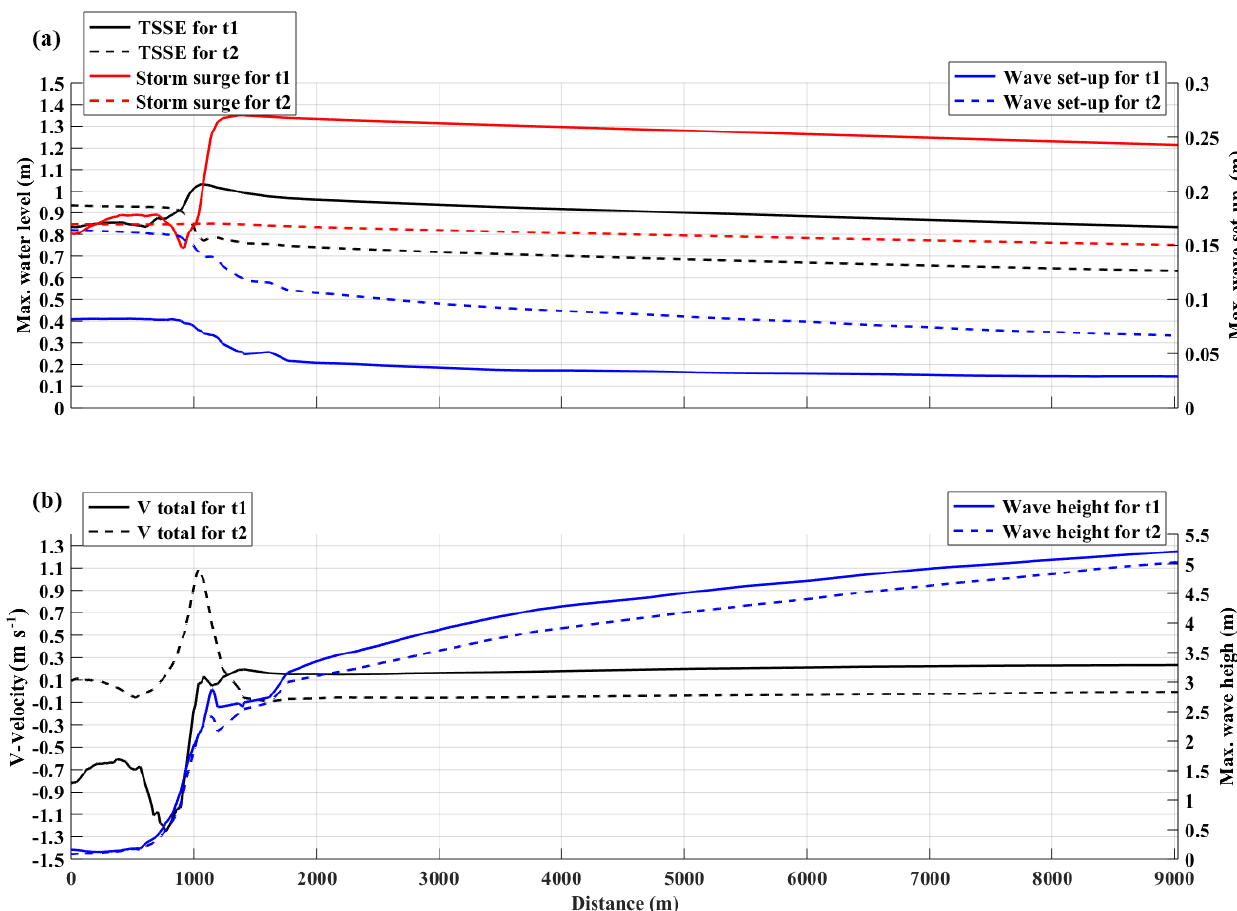
Figure 11. Modulation of the wave set-up for the ebb/flood current at the Chelem inlet during Event A. (a) TSSE, storm surge and wave set-up for times t 1 and t 2. (b) V Total component velocities and maximum wave height for t 1 and t